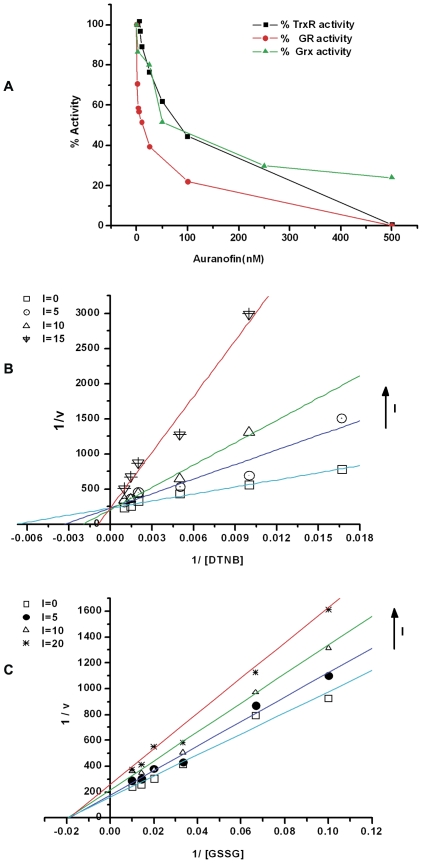
Inhibition of auranofin on enzymatic activities of recombinant SjTGR.(A) Percentages of TrxR, GR and Grx activities inhibited by different doses of auranofin with DTNB, GSSG or HED as substrate. (B) Inhibition constant () values of auranofin on recombinant SjTGR in the TrxR assay. The straight lines were fitted on the basis of the reciprocal of concentration of substrate and initial velocity. The concentrations of auranofin were 0 nM, 5 nM, 10 nM and 15 nM, and DTNB ranged from 60 to 1,000 µM. (C) Inhibition constant () values of auranofin on SjTGR in the GR activity assay. The straight lines were fitted on the basis of the reciprocal of concentration of substrate and initial velocity. The concentrations of auranofin were 0 nM, 5 nM, 10 nM and 20 nM, and GSSG ranged from 10 to 100 µM.